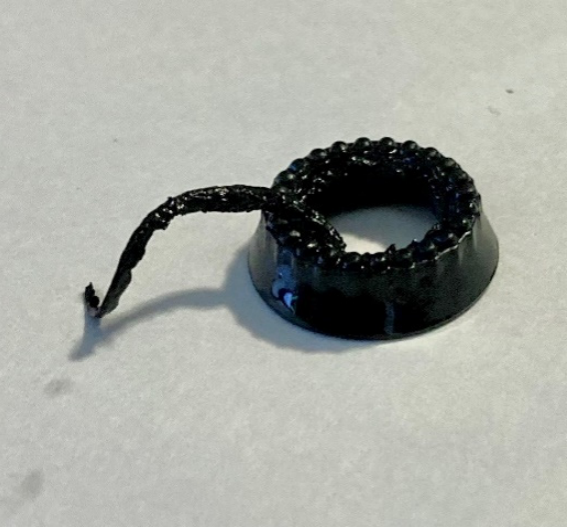
Figure 17. Failure mode of the proportioning valve lower seal during reliability testing.